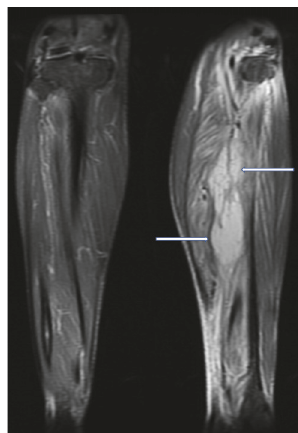
Figure 2: Coronal, T2 weighted, fat saturated, STIR MR image showing loculated fluid signal within the tibialis posterior muscle (thick white arrows), suggestive of a collection. Also noted are dif- fuseT2 hyperintense signal changes in the surroundingmusculature (thin white arrows), compatible with myositis.